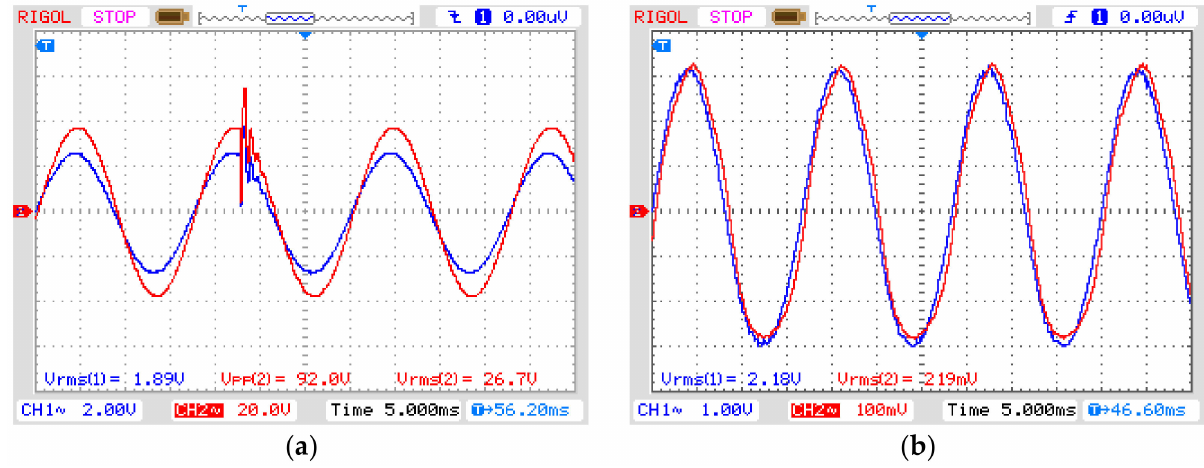
Figure 14. Impulsive transient disturbance. ( a ) CH1: input signal from signal generator to amplifier, CH2: amplifier output voltage (vertical axis: 2 V/div (CH1) and 20 V/div (CH2), horizontal axis: 5 ms/div); ( b ) CH1: OVT input voltage, CH2: OVT output voltage (vertical axis: 1 V/div (CH1) and 100 mV/div (CH2), horizontal axis: 5 ms/div).